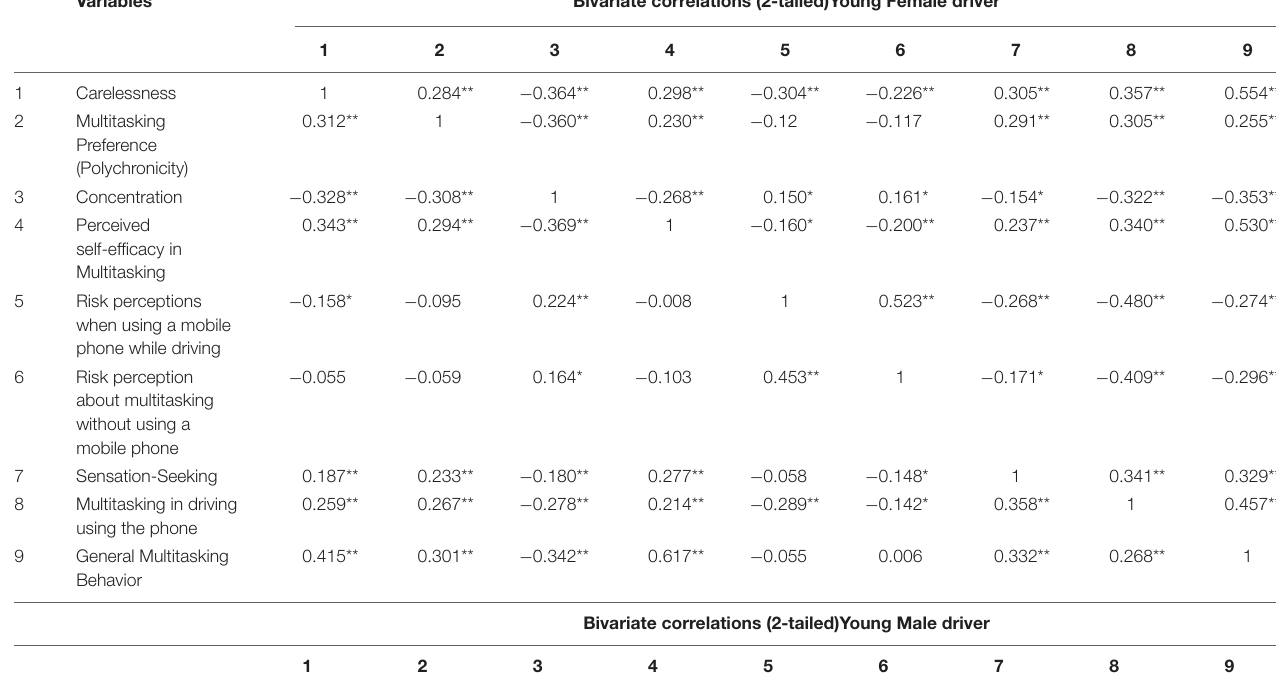
TABLE 3 | Pearson bivariate correlations of the investigated variables. Variables Bivariate correlations (2-tailed)Young Female